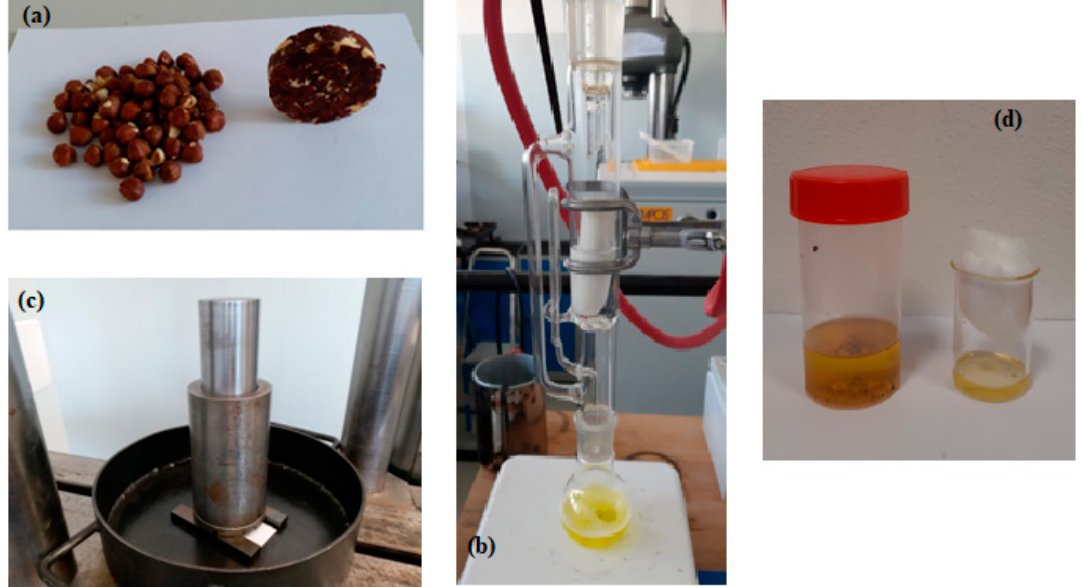
Figure 1. Set up of compression test and Soxhlet extraction: ( a ) hazelnut kernels and seed cake after compression; ( b ) Soxhlet extraction setup for kernel oil content determination; ( c ) a pan holding the pressing vessel with a plunger placed on two separated metal bars with a piece of white paper for oil point identification similar for the compression test; and ( d ) hazelnut kernel oil from the compression test and Soxhlet extraction (covered with cotton wool).